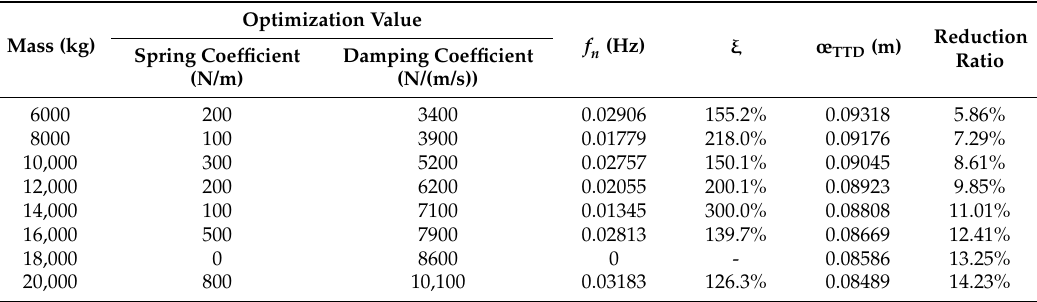
Table 4. Optimal results of spring and damping coefficients by method of exhaustion.